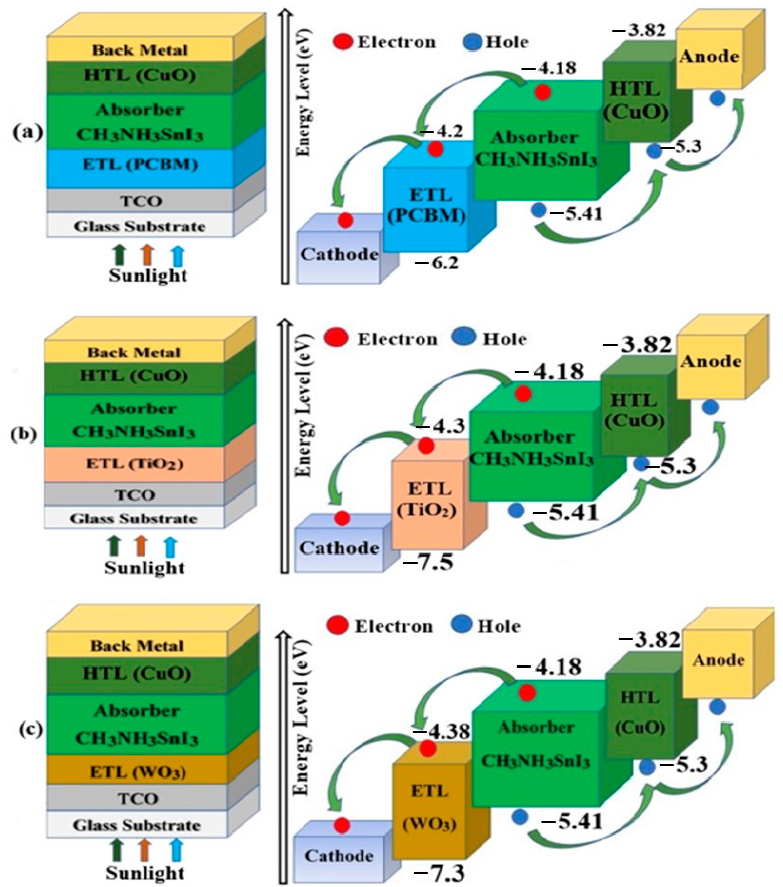
Figure 2. Schematic diagram of proposed perovskite solar cell’s structure and Energy band alignment; ( a ) Structure 1, ( b ) Structure 2 and ( c ) Structure 3.